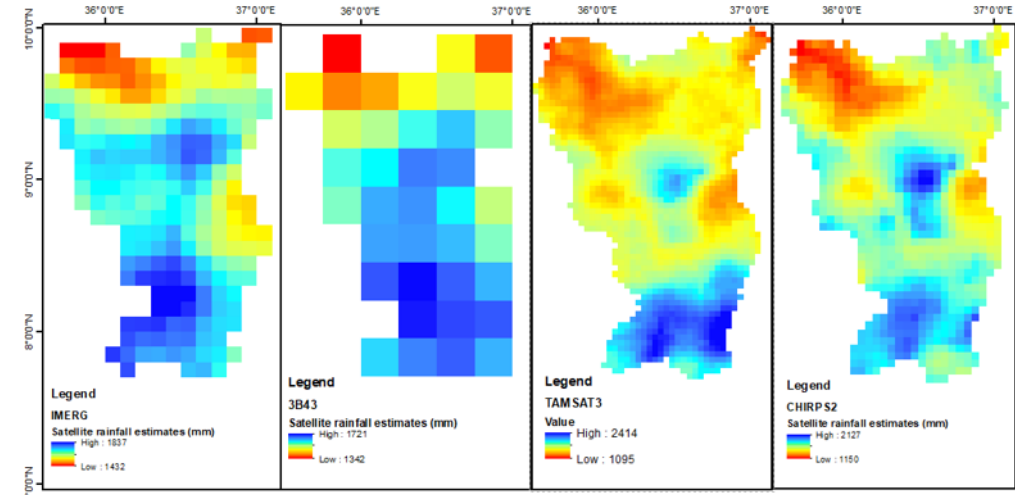
Figure 2. Spatial mean annual rainfall distribution of the four SREs for the DRB (2001 to